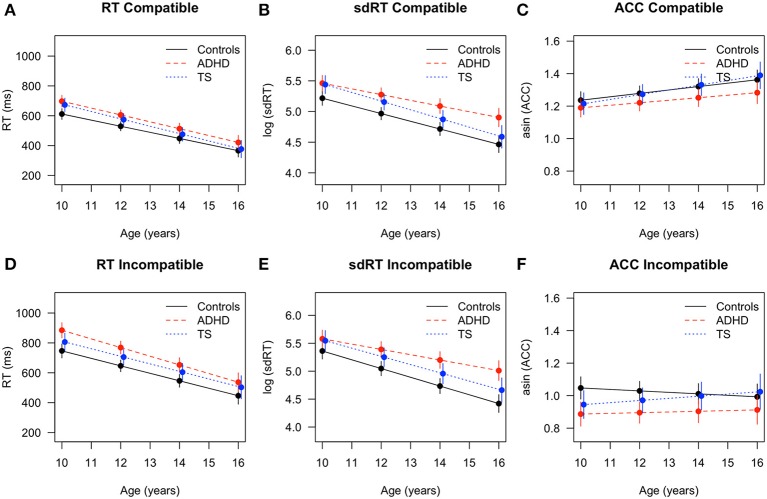
Flanker task performance with fitted values and 95% confidence intervals for children with TS (blue), children with ADHD (red), and control children (black). RT in (A) compatible and (D) incompatible trials, sdRT in (B) compatible and (E) incompatible trials, asin ACC in (C) compatible and (F) incompatible trials. ADHD, Attention-Deficit/Hyperactivity Disorder; TS, Tourette Syndrome; RT, reaction time; sdRT, standard deviation of reaction time; asin ACC, arcsine transformation of accuracy.